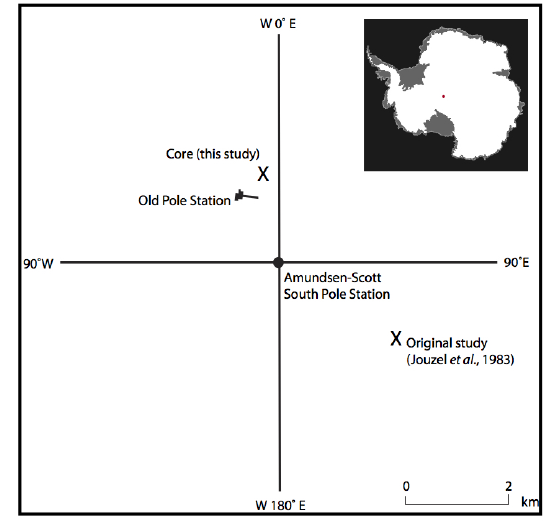
Figure 1. Location of cores investigated at the geographic South